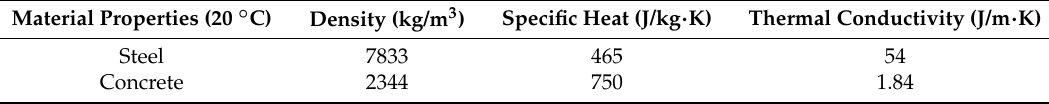
Table 1. Thermo-physical properties of steel and